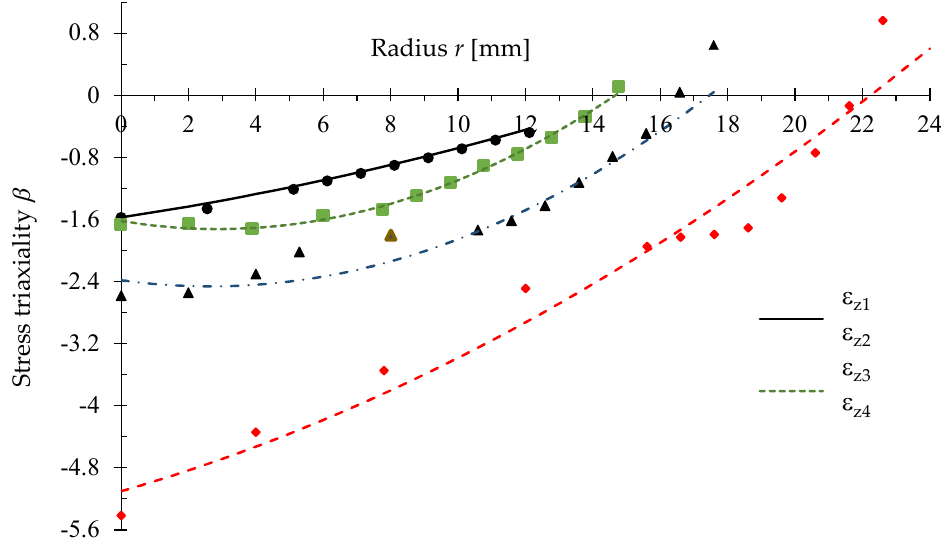
Figure 20. Distribution of stress triaxiality along the equatorial radius for different degrees of defor- mation.